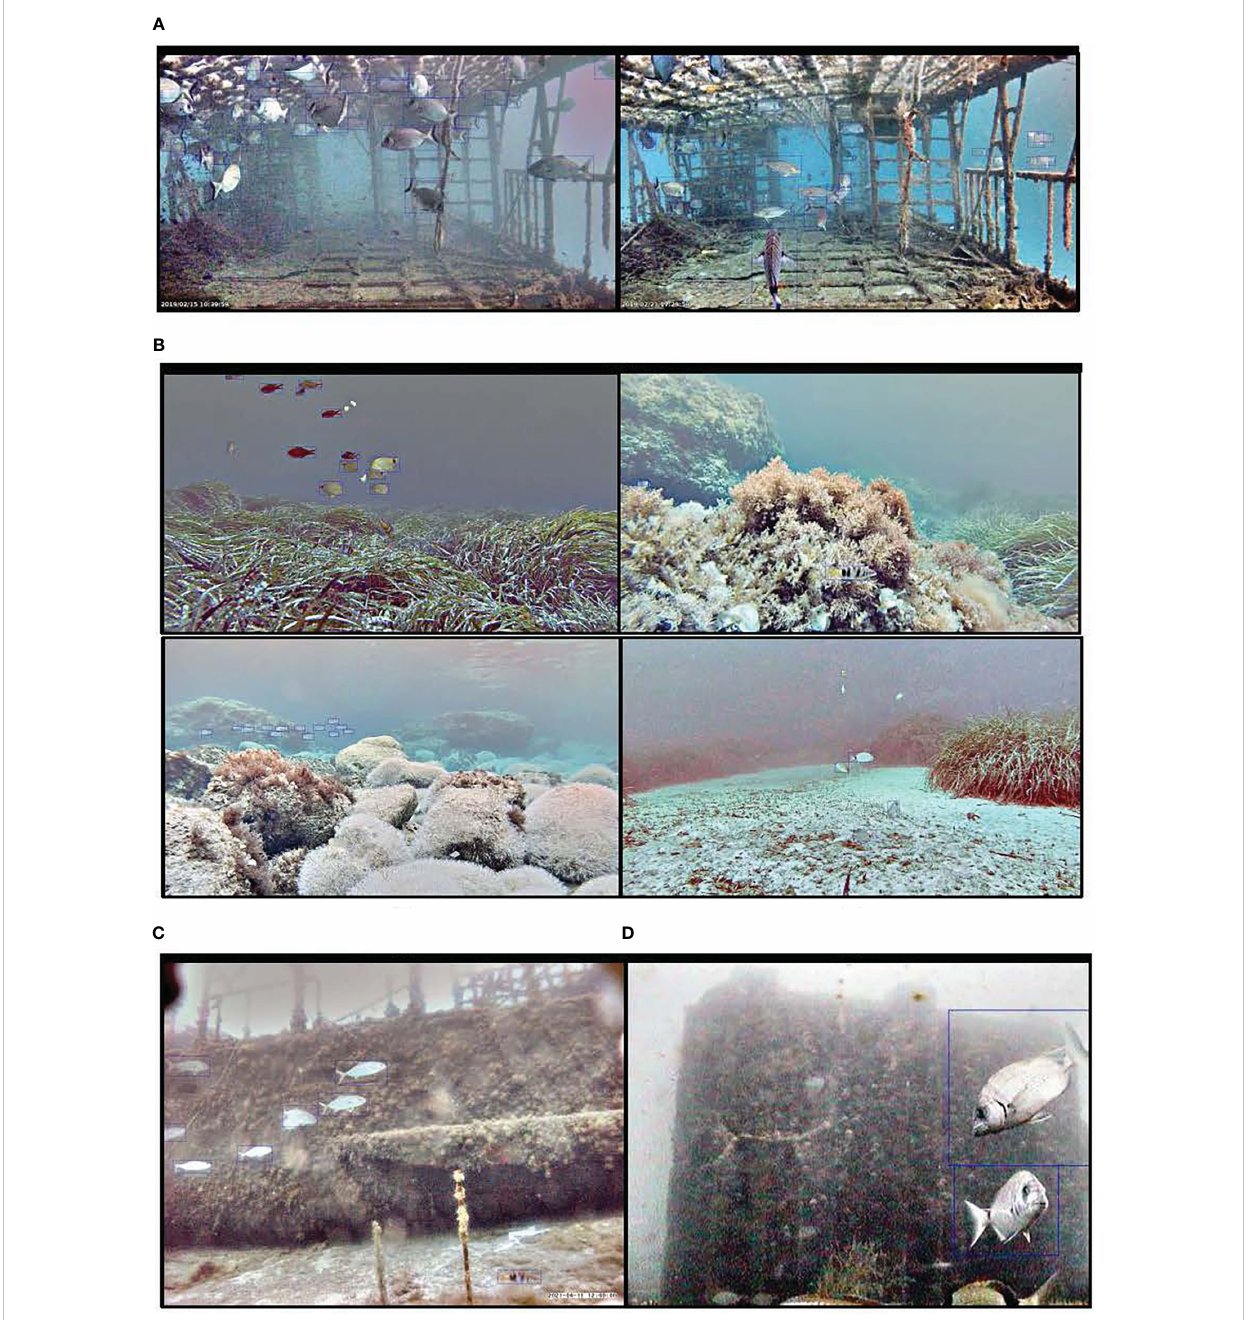
FIGURE 1 Example images from the main coastal Mediterranean datasets (A) fi xed observatory, (B) varied coastal bottoms, and two other test datasets (C) fi xed observatory in Mallorca, (D) fi xed observatory in